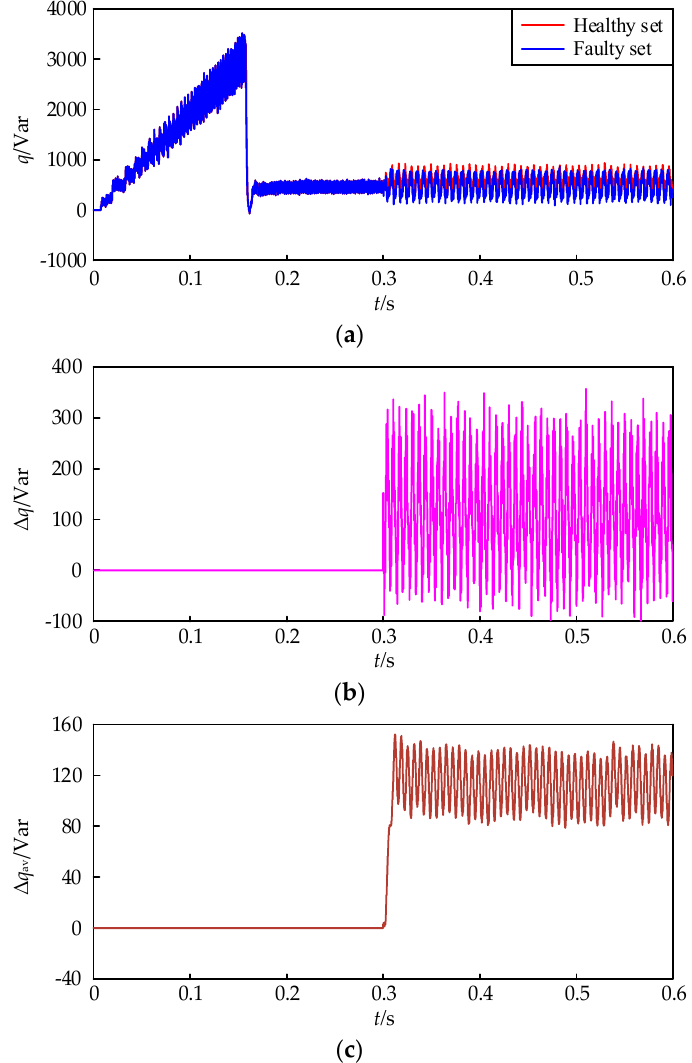
Figure 12. The curve of the instantaneous reactive power before and after the ISCF occurs: ( a ) q of two sets; ( b ) The difference ∆ q between two sets; ( c ) Real-time average value ∆ q av in 0.01